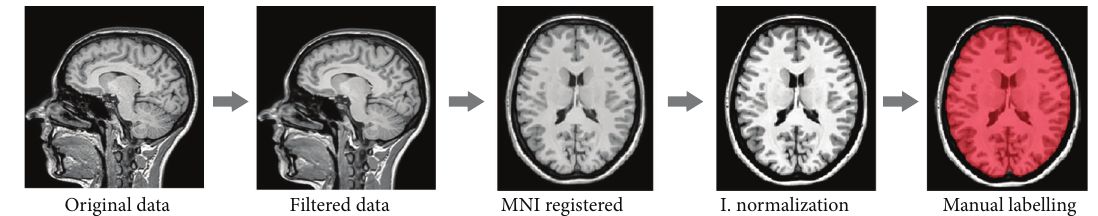
Figure 3: Template library construction